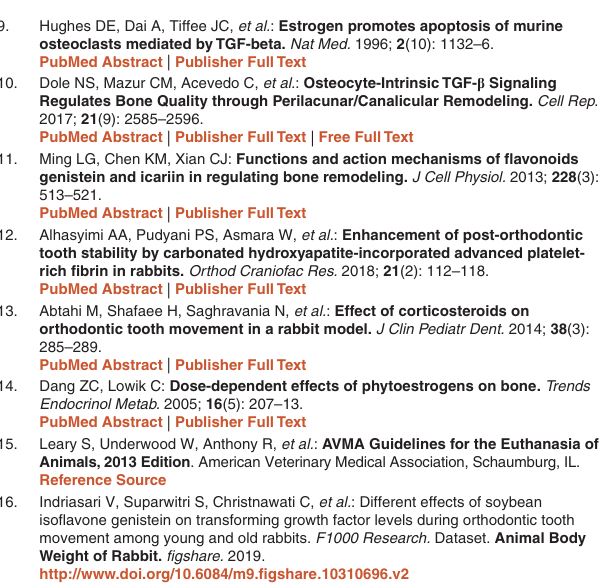
statistical analysis) Figshare: Animal Body Weight of Rabbit. https://doi.org/10.6084/ m9.figshare.10310696 16